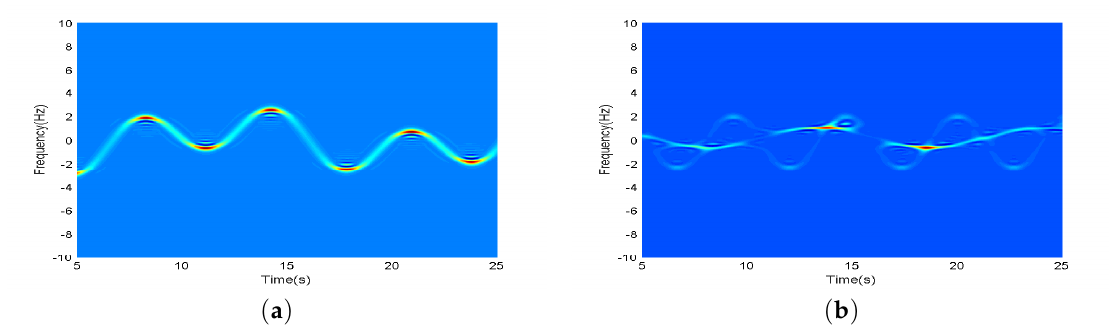
Figure 4. ( a ) is the mono-component adaptive results; ( b ) is the multi-component adaptive results.